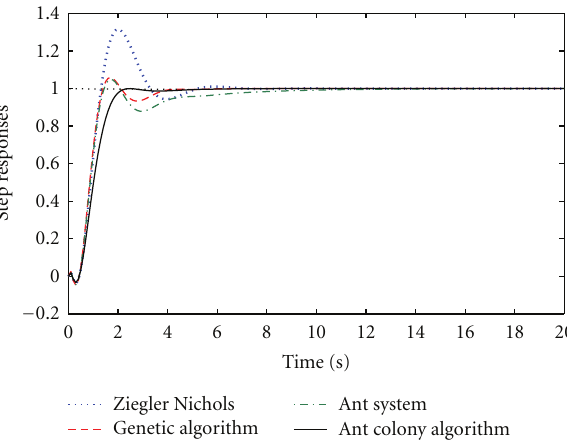
Figure 3: Comparison of step responses of the G 1 ( s )